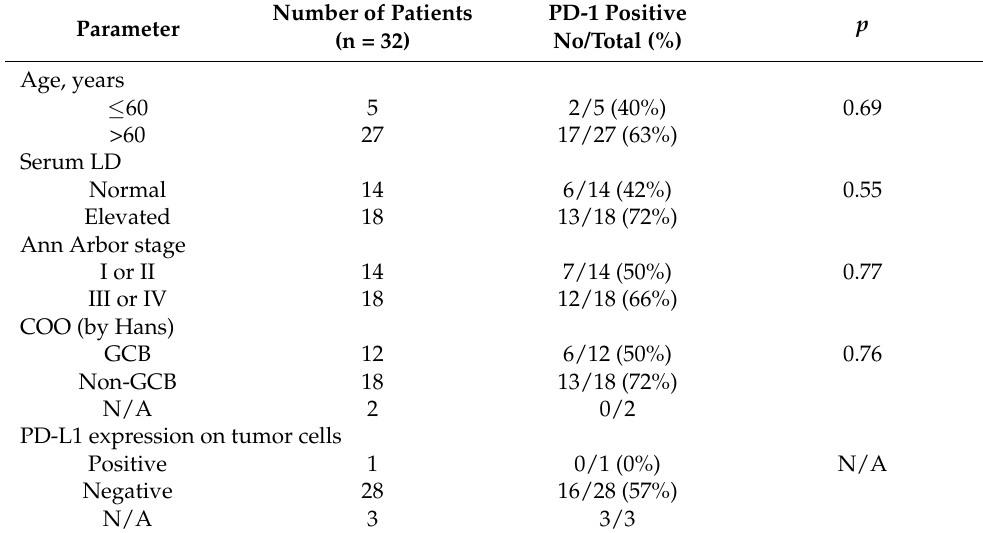
Figure 2. PFS and PD-1 expression on DLBCL cells. Patients with de novo DLBCL treated with immunochemotherapies and expressing PD-1 on lymphoma cells showed significantly poorer PFS. PFS, progression-free survival; PD-1, programmed death-1; DLBCL, diffuse large B-cell lymphoma. Table 3. Clinical relevance of PD-1 expression on lymphoma cells.